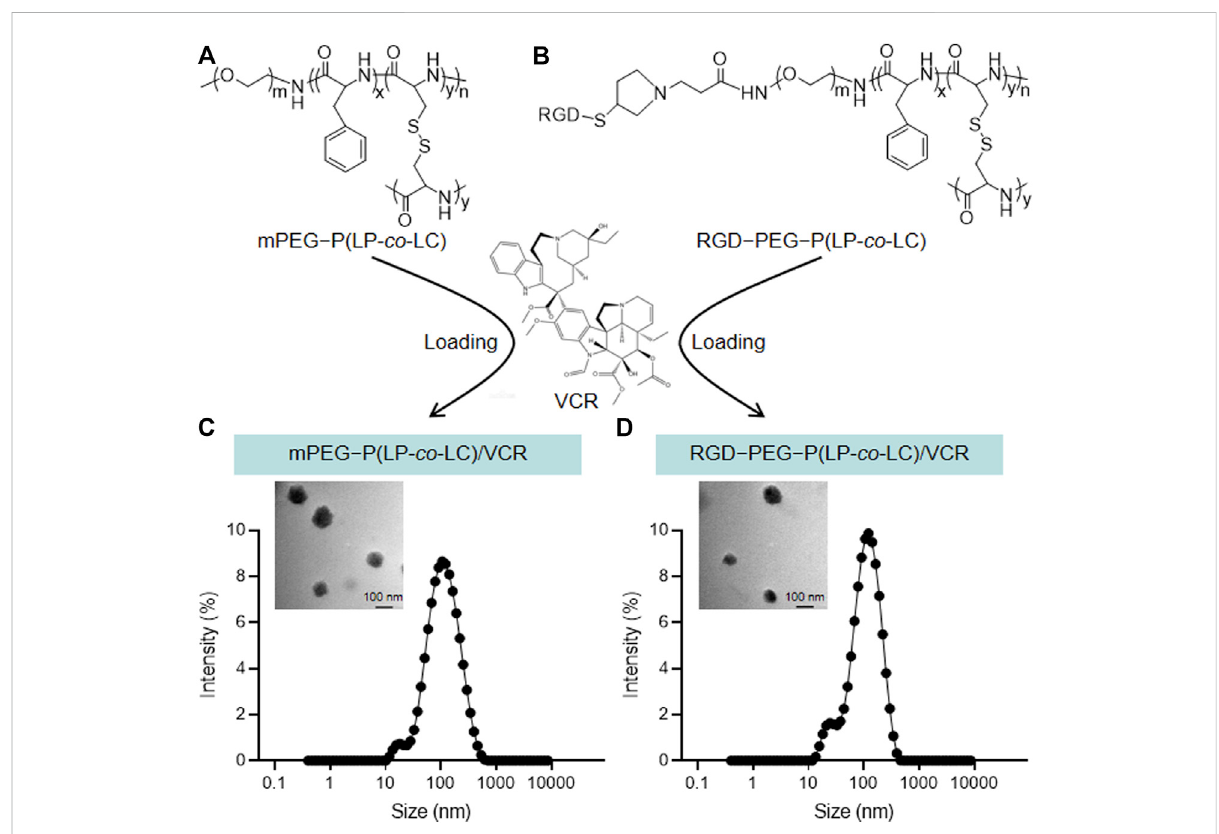
FIGURE 1 (A,B) ThechemicalstructuresofmPEG − P(LP- co -LC)andRGD − PEG − P(LP- co -LC). (C,D)